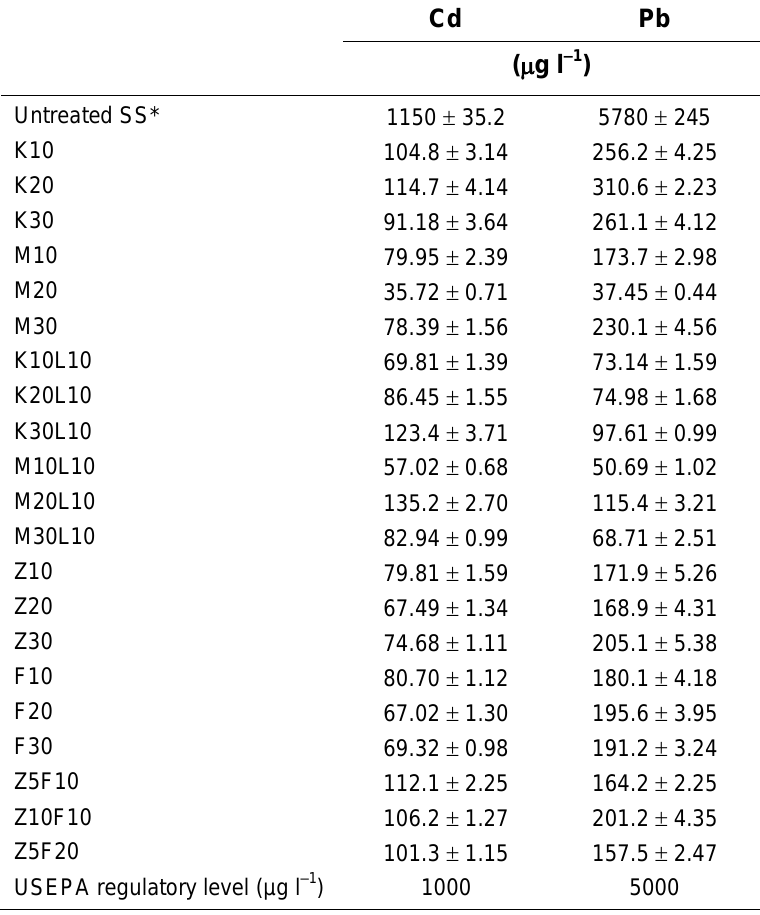
Results of the TCLP Leaching Test (Mean Value ±